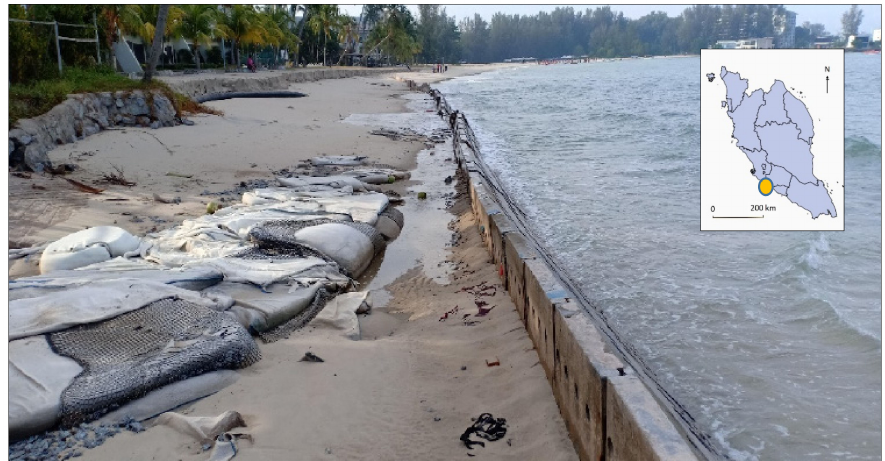
Figure 18. Damaged geotextile-tube replaced with concreted structure protection